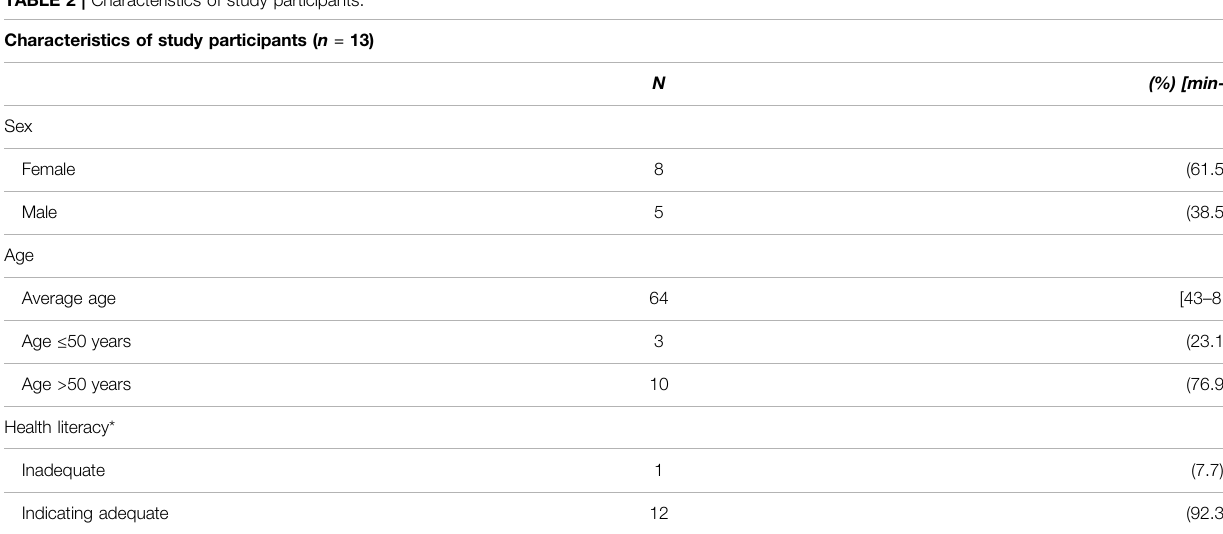
TABLE 2 | Characteristics of study